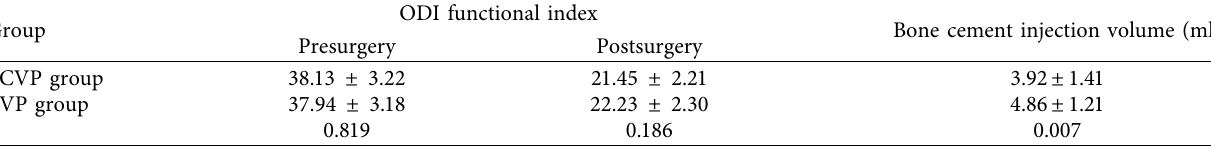
Table 3: Preoperative and postoperative ODI score and bone cement injection volume ( x ± s ).